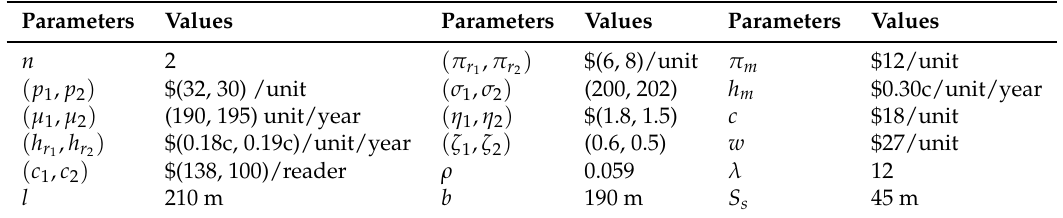
Table 5. Input values of the parameters for Example 2.